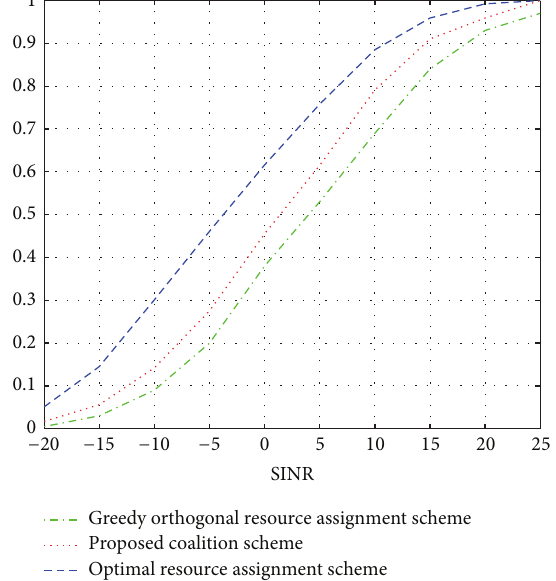
Figure 4: Comparison in terms of the cumulative distribution function of different